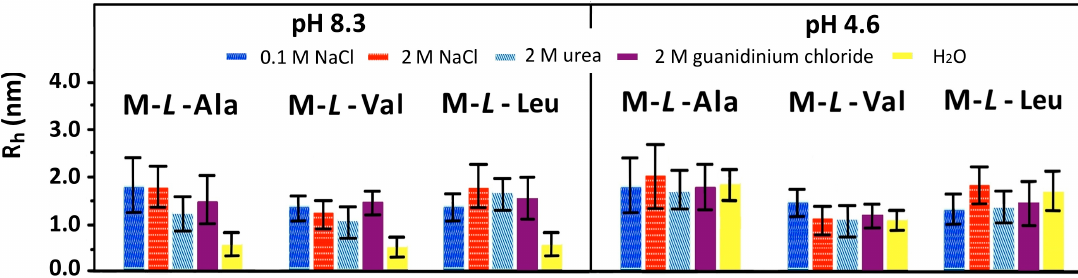
Figure 7. PAAC hydrodynamic radii from DLS in: 0.1 M and 2 M NaCl, 2 M urea, 2 M guanidinium chloride and plain water. Operational conditions: polymer concentration 1 mg mL − 1 , 25 °C.